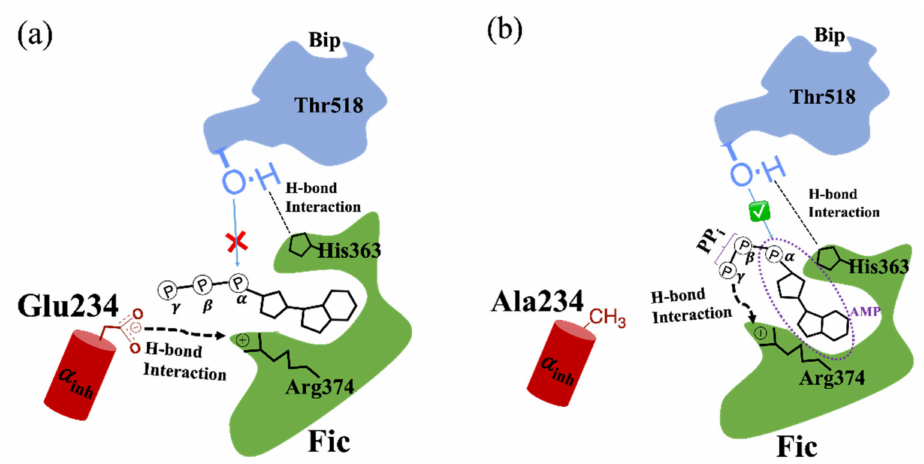
Figure 5. The general inhibition mechanism of Glu234 in HYPE with the target BiP protein. ( a ) for Glu234 ( b ) for E234A. AMPylation transfers AMP of ATP molecule to Tyr/Thr/Ser residues from target protein and leaves the PPi (inorganic